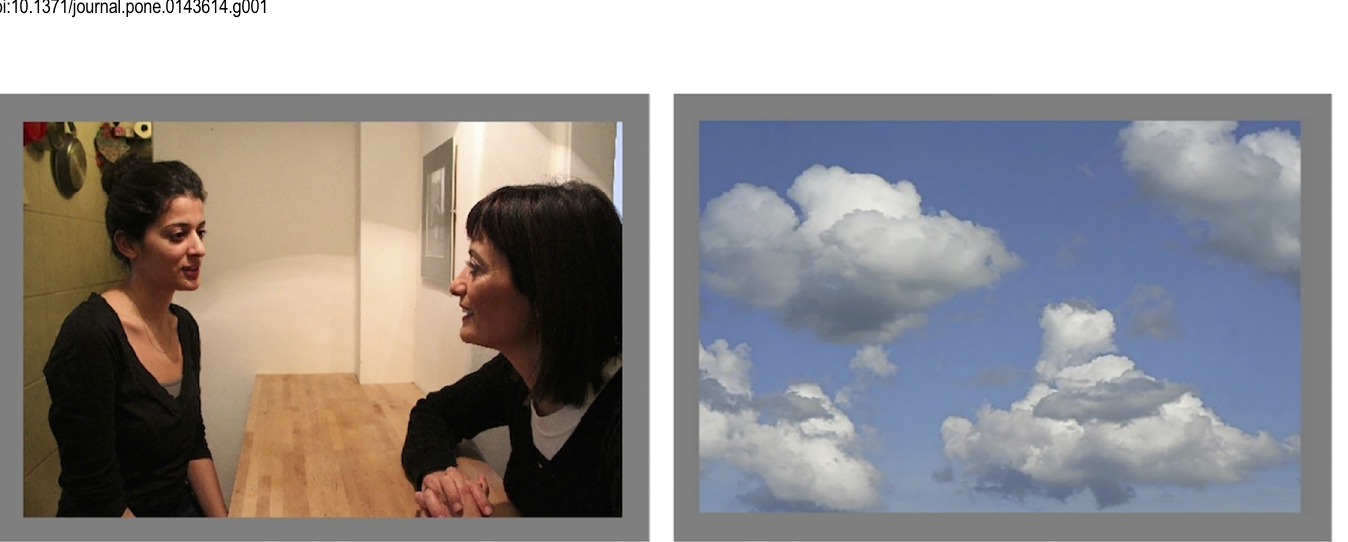
Fig 2. The two other action context images. The ‘ drink ’ context (left) and the ‘ neutral ’ context (right).